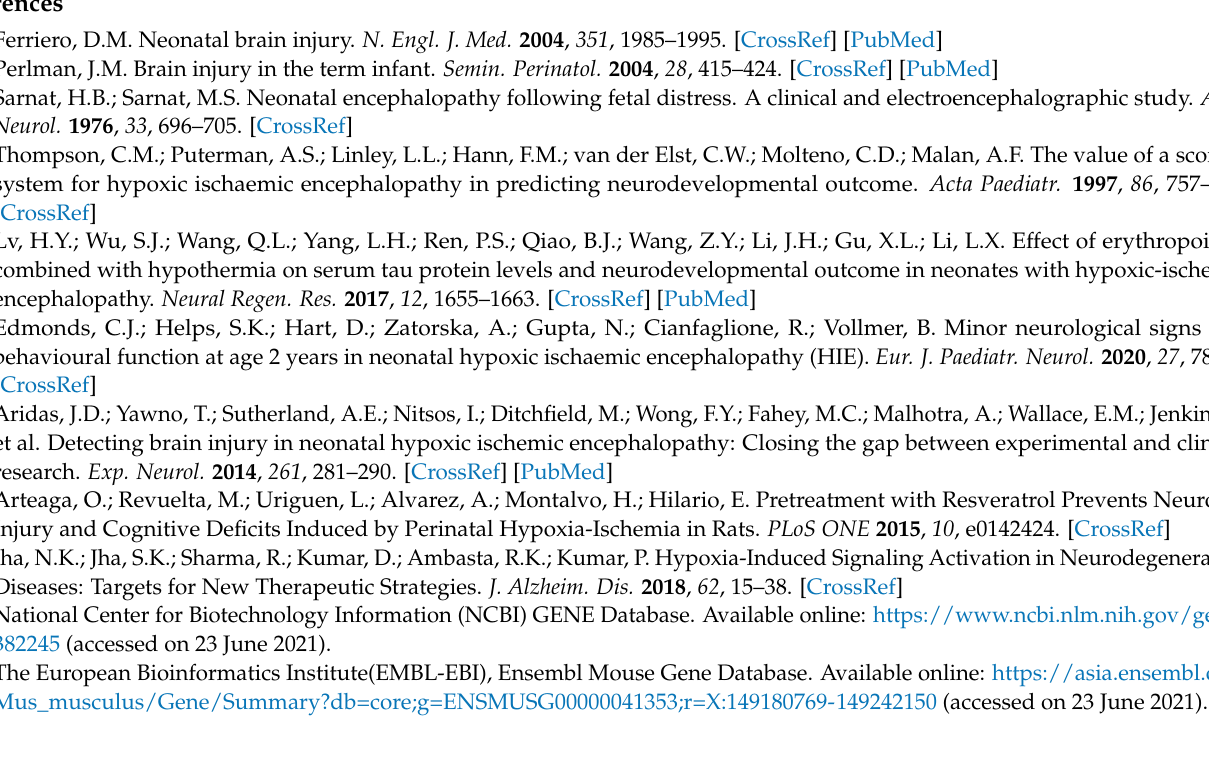
Figure S2: Schematics diagram of the relative position of siRNA on Tmem29 β transcripts; Figure S3: Gating Strategy for apoptotic cells determination in OGD and GD treated Neuro2a